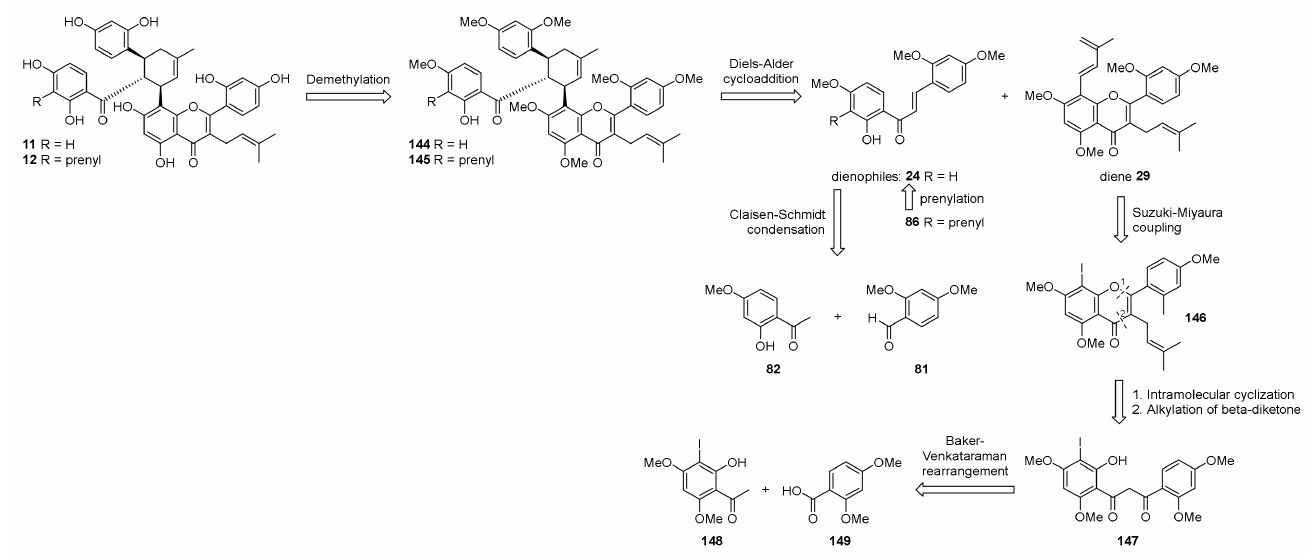
Figure 48. Retrosynthesis of kuwanons G and H ( 11 and 12